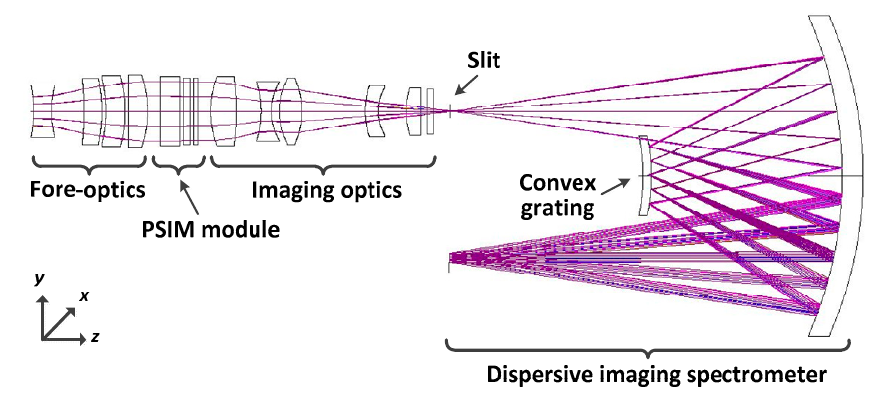
Figure 2. Schematic layout of the fieldable CDISP.